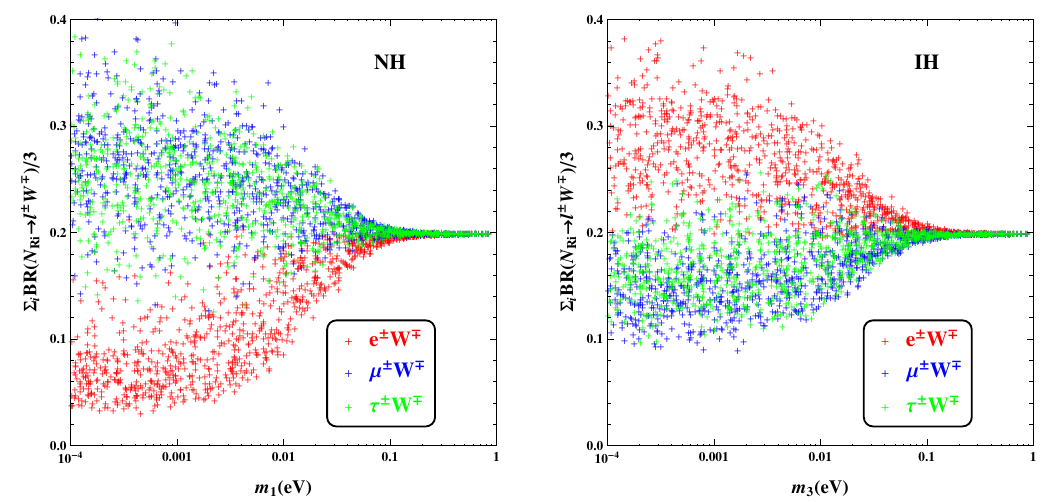
Figure 6 . The averaged branching ratios of N Ri as a function of the lightest neutrino mass for normal (left panel) and inverted hierarchy (right) at m N